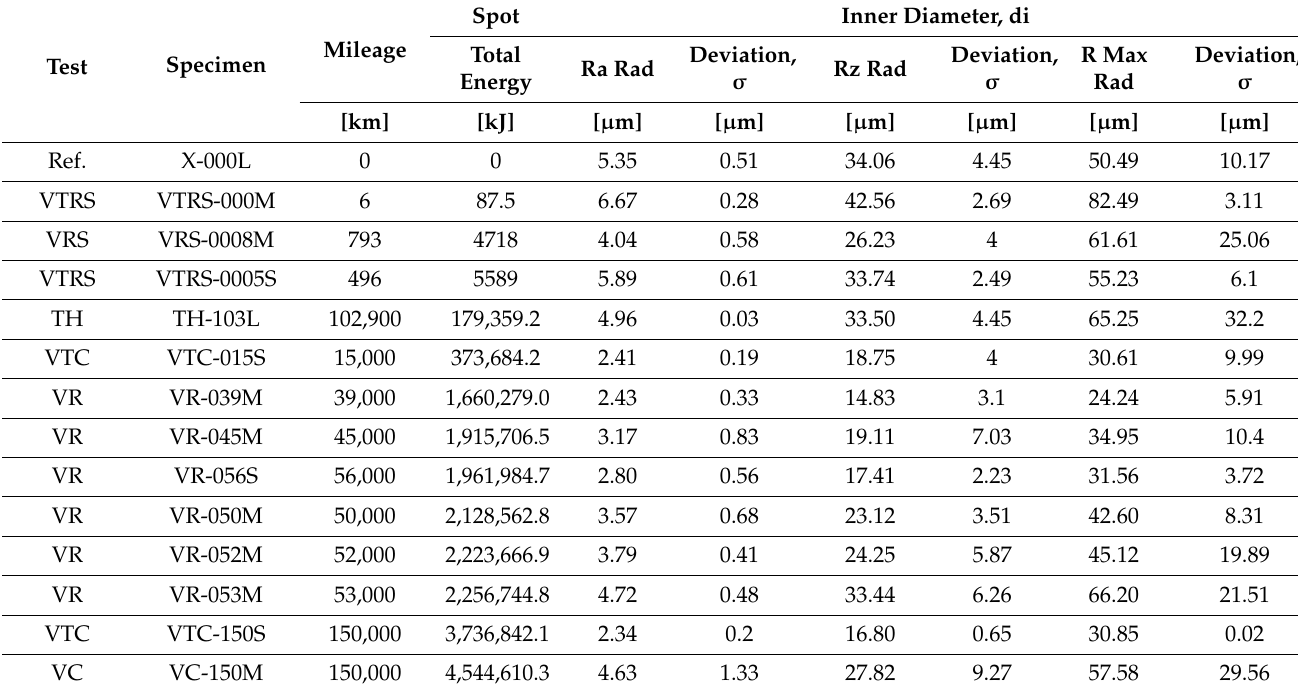
Table A2. Summary of the surface roughness values before (reference) and after different tests: inner diameter, radial direction.